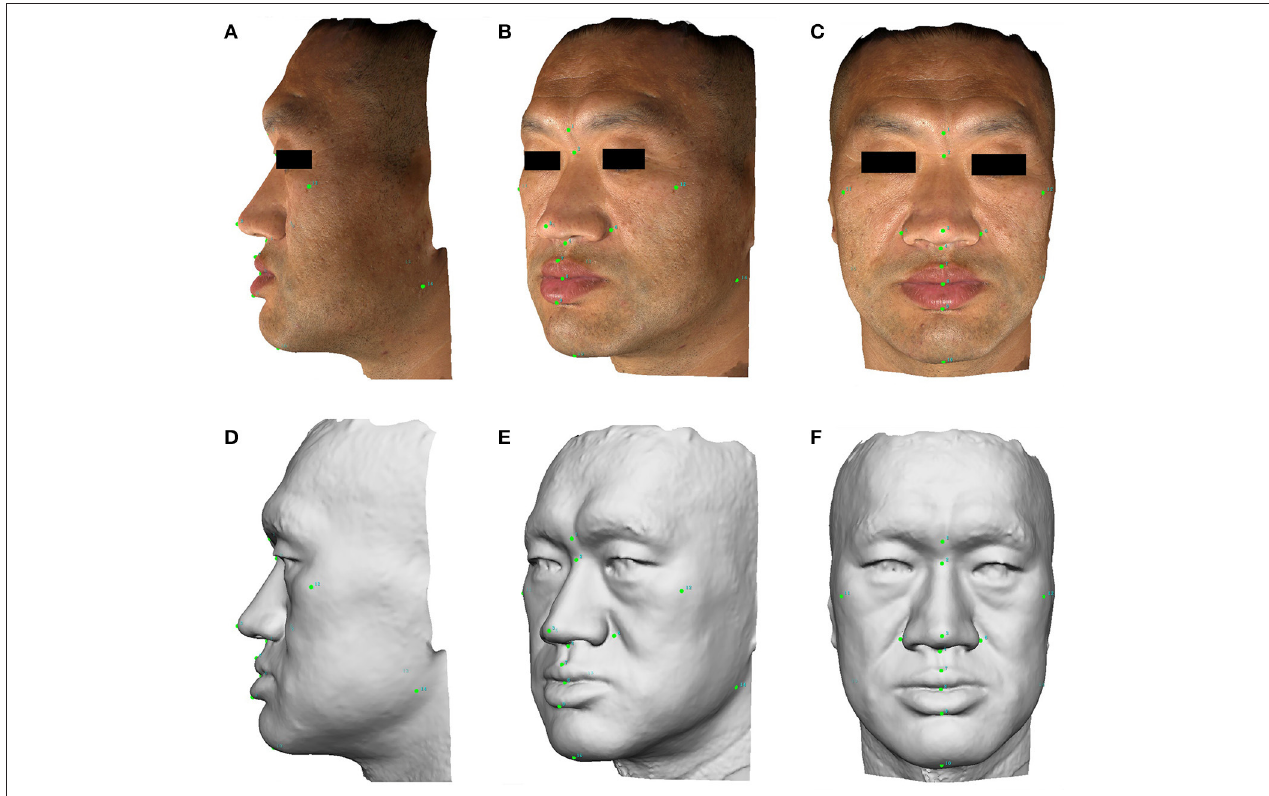
FIGURE 1 | The lateral, anterolateral, and anterior images of facial 3D photography for a male acromegaly patient. Points are labeled on the actual 3D images (A–C) and gray-mode 3D images (D–F) for the measurement of facial lines and angles. A written informed consent was obtained from the individual for the publication of this